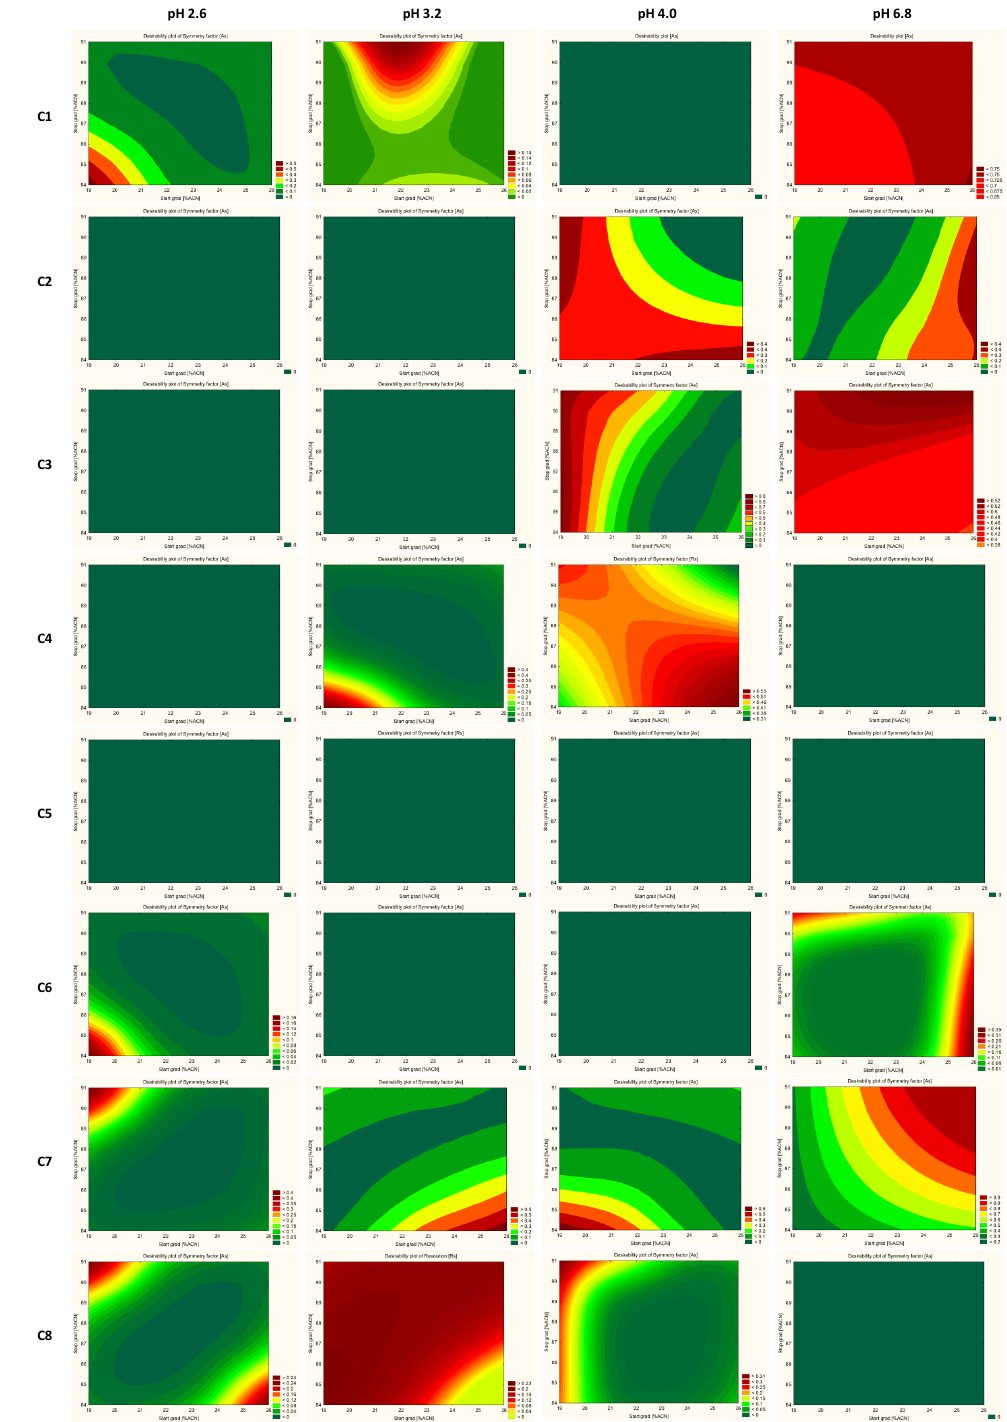
Figure 5. Screening experiment results showing the interaction effect of columns, % of organic solvent at the start and end gradient, and pH with CMAs as a desirability plot of symmetry factors (A S ). C1—ZORBAX Eclipse Plus C18 (2.1 × 50 mm, 1.8 µ m, Agilent Technologies), C2—Kinetex EVO C18 (2.1 × 50 mm, 1.7 µ m, Phenomenex), C3—ACQUITY UPLC BEH C18 (2.1 × 50 mm, 1.7 µ m Waters), C4—InfinityLab Poroshell 120 Phenyl Hexyl (2.1 × 50 mm, 1.9 µ m, Agilent Technologies), C5—Kinetex Biphenyl (2.1 × 50 mm, 1.7 µ m, Phenomenex), C6—Kinetex PFP (2.1 × 50 mm, 1.7 µ m, Phenomenex), C7—ACQUITY UPLC CSH C18 (2.1 × 50 mm, 1.7 µ m, Waters), and C8—ACQUITY UPLC CSH Fluoro-Phenyl (2.1 × 100 mm, 1.7 µ m,